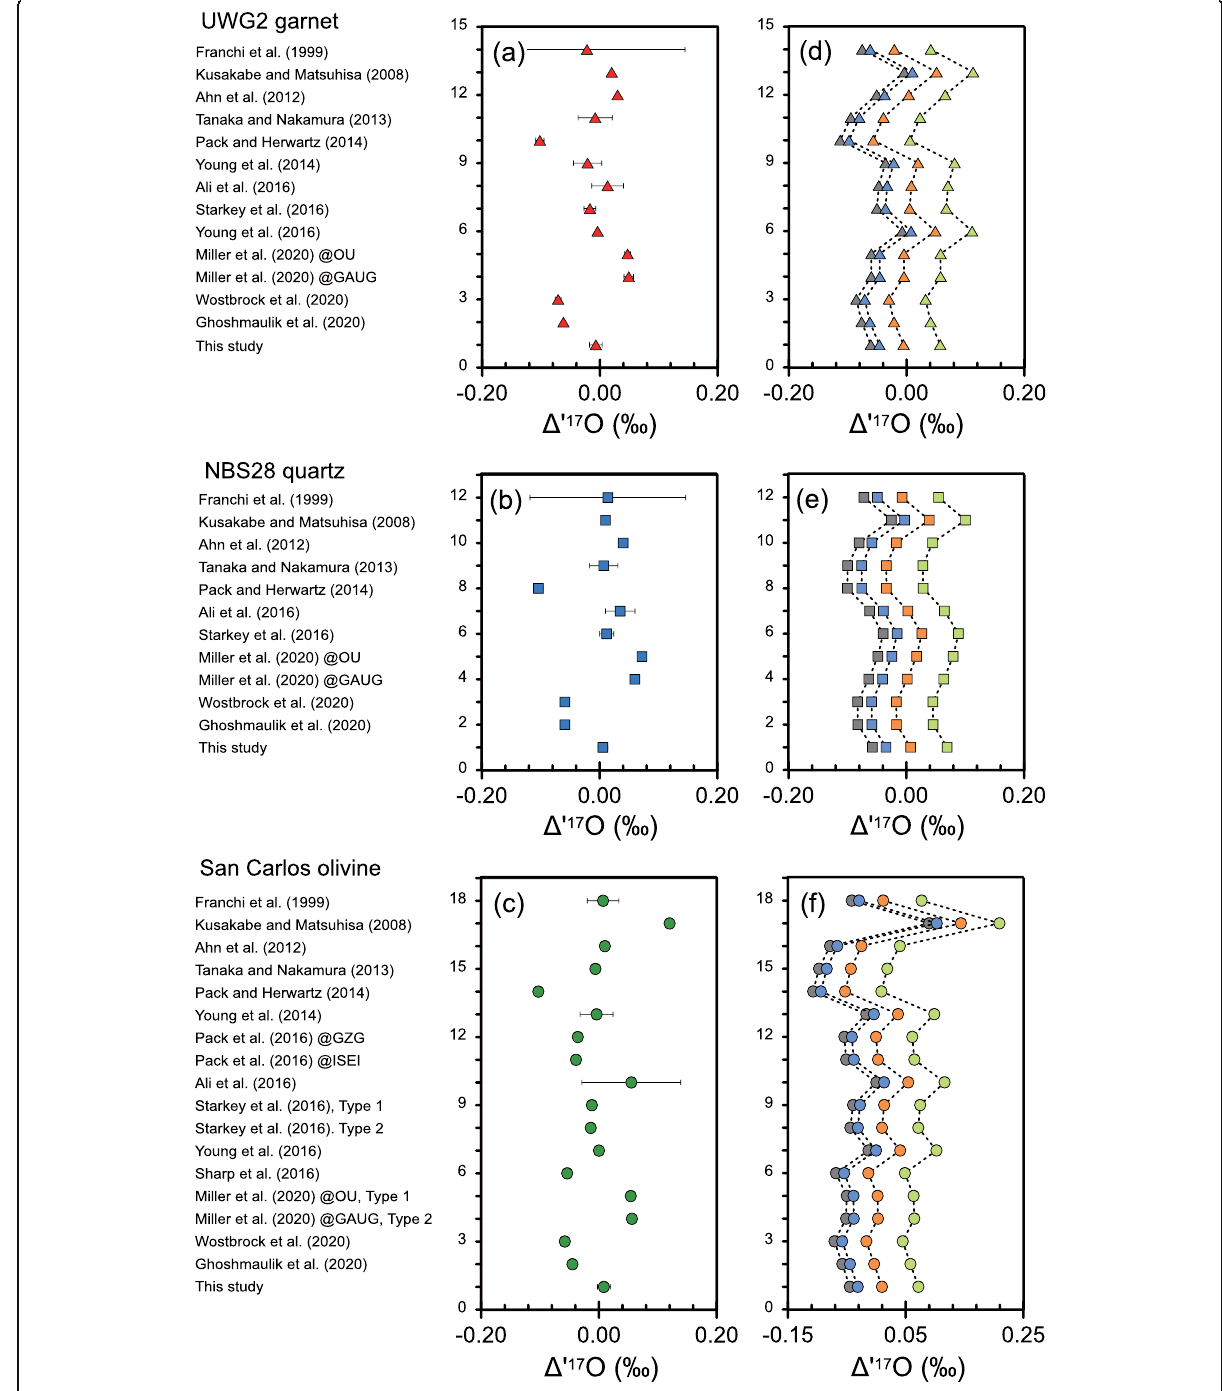
Fig. 5 Comparison of published Δ ' 17 O ( a – c ) and recalculated Δ ' 17 O using four different λ RL and γ RL ( d – f ). Gray symbol: λ RL = 0.5305 and γ RL = 0, light blue symbol: λ RL = 0.528 and γ RL = 0, orange symbol: λ RL = 0.5278 and γ RL = − 0.040, light green: λ RL = 0.5273 and γ RL = − 0.099 as mentioned in the text. The Δ ' 17 O values change significantly according to the different set of λ RL and γ